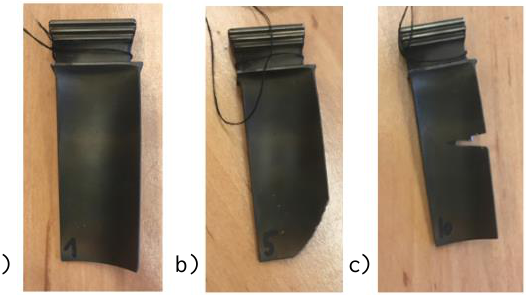
Fig. 1. Turbine blade: a) undamaged, b) damage simulating separation of the tip, c) damage simulating crack of the aerofoil